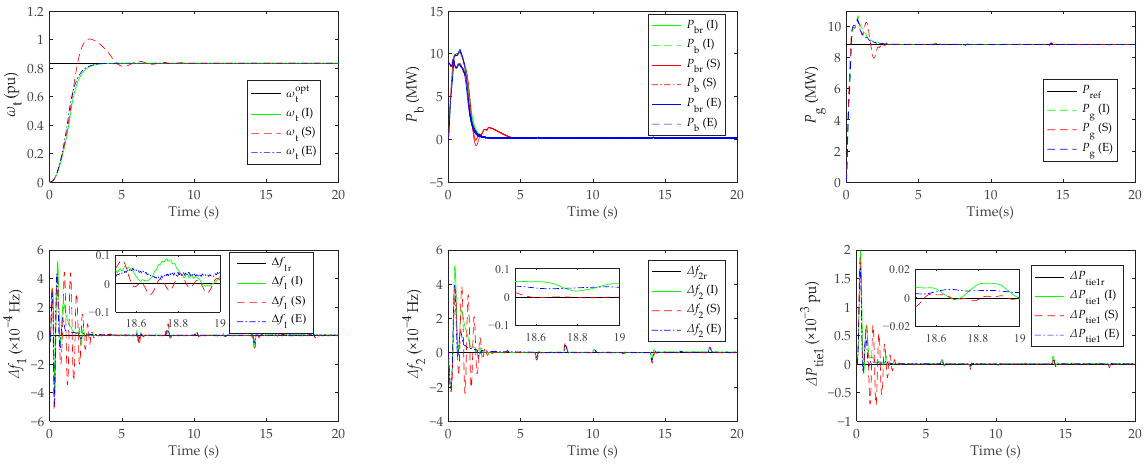
Figure 7. System outputs under different reaching laws.